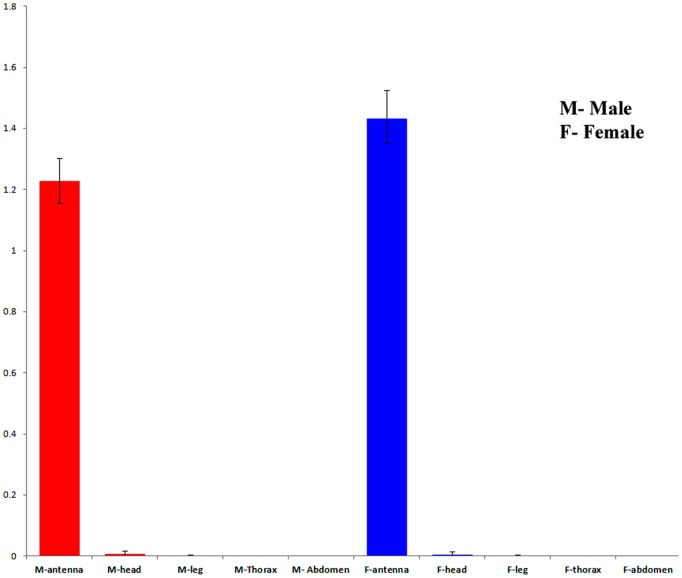
Expression pattern analysis of McinOBP1.Transcript level of M. cingulum odorant binding protein 1 (McinOBP1) in different tissues of adult male and females measured by qPCR. cDNAs were amplified with specific primers from antennae, heads (without antennae),thoraxes, abdomens, legs, and abdomen.